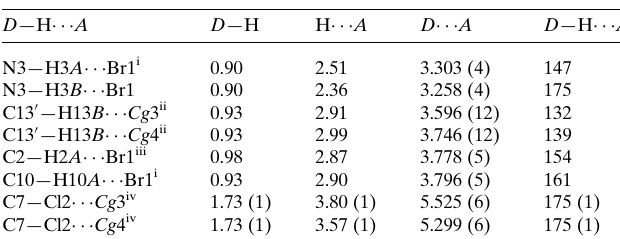
Table 1 Hydrogen-bond geometry (A˚ , (cid:4) ).